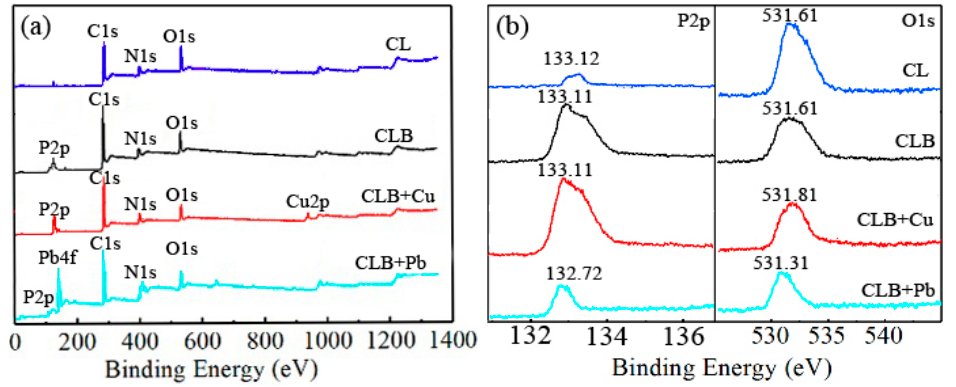
Figure 5. X-ray photoelectron spectra(XPS) of CL, CLB, and CLB before and after 0.3 mM Cu(II) and 0.3 mM Pb(II) adsorption, respectively. ( a ); XPS analysis of full spectrum; ( b ): P2p and O1s region